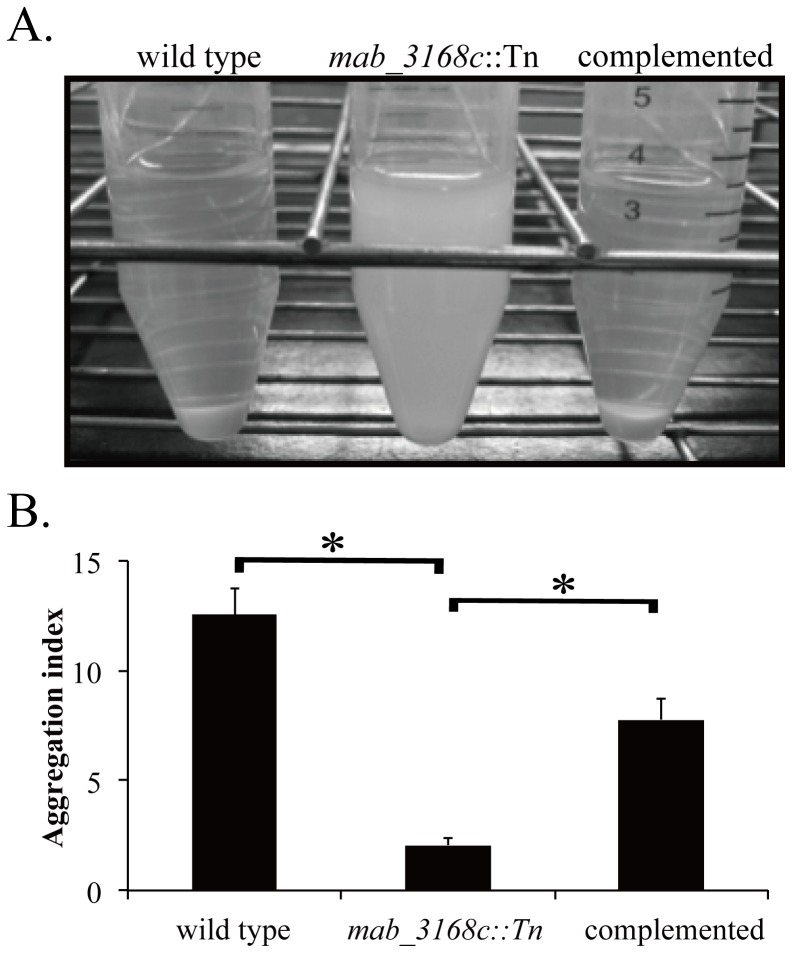
Aggregation of M. abscessus cells.(A) M. abscessus cells of the 3 different strains were inoculated in 7H9 broth plus 10% OADC at an OD600 of approximately 0.1. The cultures were incubated at 37°C for 3 days and then placed at room temperature for 3 hours. (B) Aggregation index of each strain was calculated as the ratio of optical density (OD600) of aggregated cells to that of dispersed cells. This experiment was repeated three times. Data were analyzed by one-way ANOVA and Fisher’s PLSD test. The asterisk sign (*) represents p<0.05 of mab_3168c::Tn versus wild type or mab_3168c::Tn versus complemented strain.